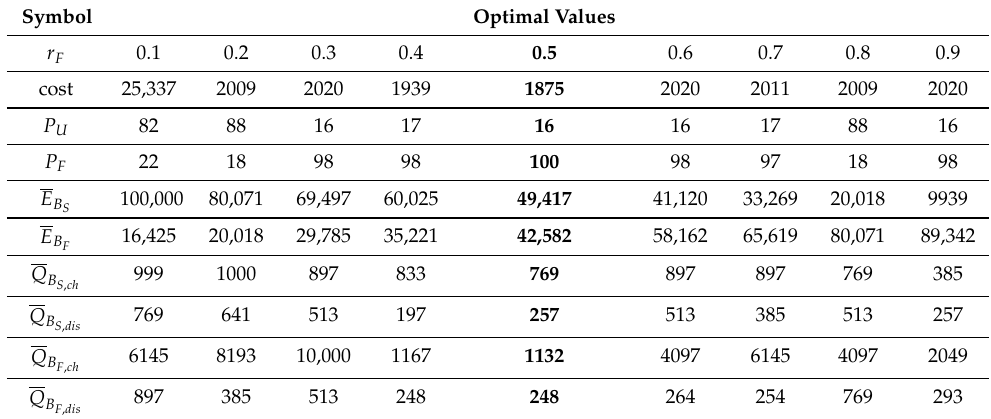
Table 4. List of the elements for optimization with the fuel-cell ratio fixed.